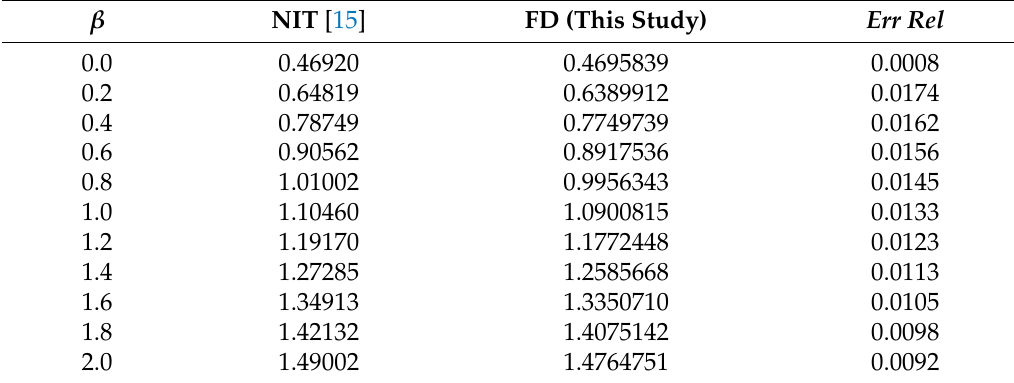
d 2 u ( 0 ) , and comparison with results by dx 2